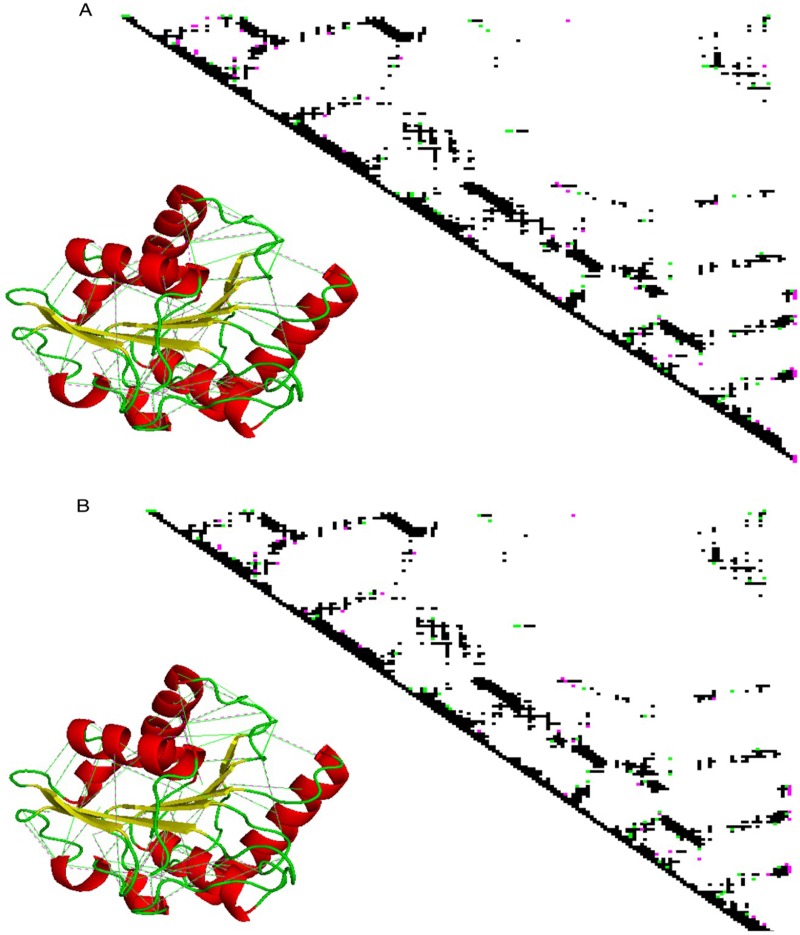
Graphical illustration of unique contacts formed in A mut 1 vs. 1i6w along with the cartoon representation of mut 1 showing its unique contact.B mut 2 vs. 1i6w along with the cartoon representation of mut 2 showing its unique contact.